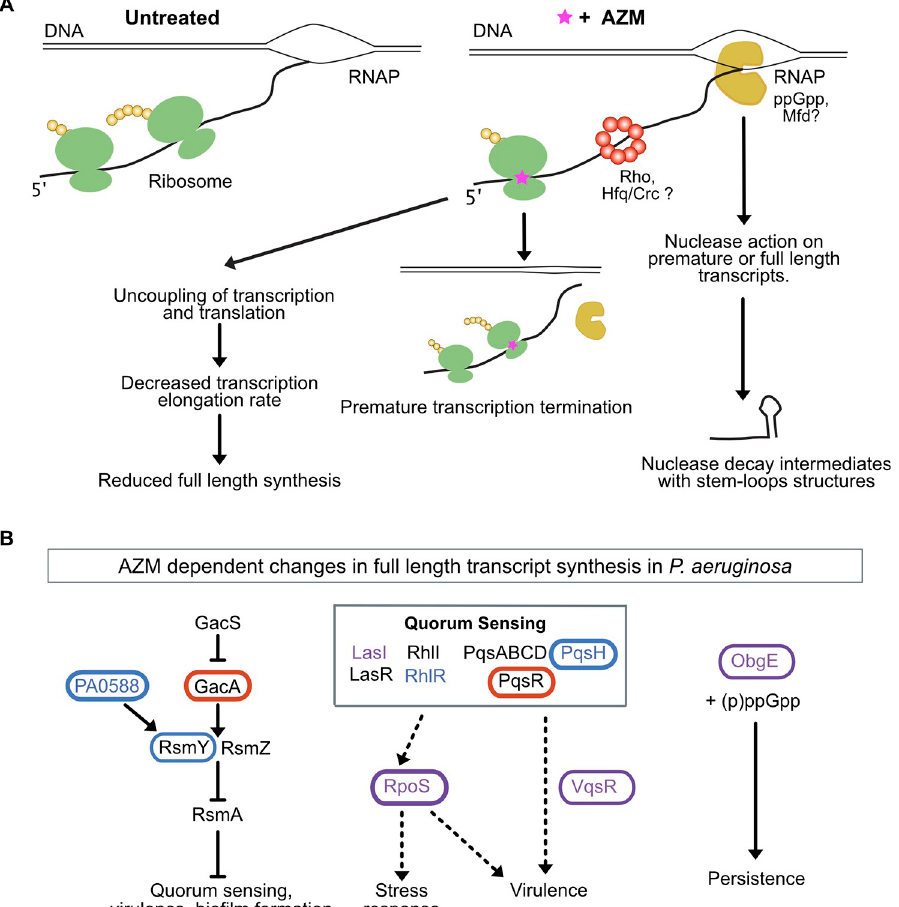
Fig 5. Model of P . aeruginosa response to azithromycin. (A) Altered premature 3’-end formation is observed in up and down-regulated genes/operons of P . aeruginosa in response to AZM. AZM induces changes in premature transcription termination, transcription pausing and/or transcription elongation rate, due to transcription-translation uncoupling or altered RNA polymerase pausing in response to ppGpp, thereby resulting in gene expression changes. Alternatively, nuclease action on premature and full-length transcripts could contribute to gene expression changes in response to AZM. Different molecular mediators of transcriptional control that could affect transcriptional changes are indicated–Rho and Mfd (transcription termination), ppGpp (RNAP pausing), and Hfq (sRNA action and nuclease recruitment). (B) Impact of AZM on gene expression of key P . aeruginosa regulators. Network diagram depicts several genes found to be differentially regulated and exhibit premature transcription termination within the GacS/GacA signal transduction system, quorum sensing systems, and stringent response regulators. These genes, and their regulons, have been shown to be highly interconnected, therefore only a subsection of interactions are shown here. Oval outlines indicate that a gene was differentially expressed upon AZM treatment as detected by DESeq2. Significant hits for altered relative I/FL ratio upon AZM treatment is shown by color of the text. Genes with altered expression or early transcription termination in biofilms are indicated in blue, in planktonic culture in red, and in both conditions in purple. The nature of the expression changes is indicated in Fig